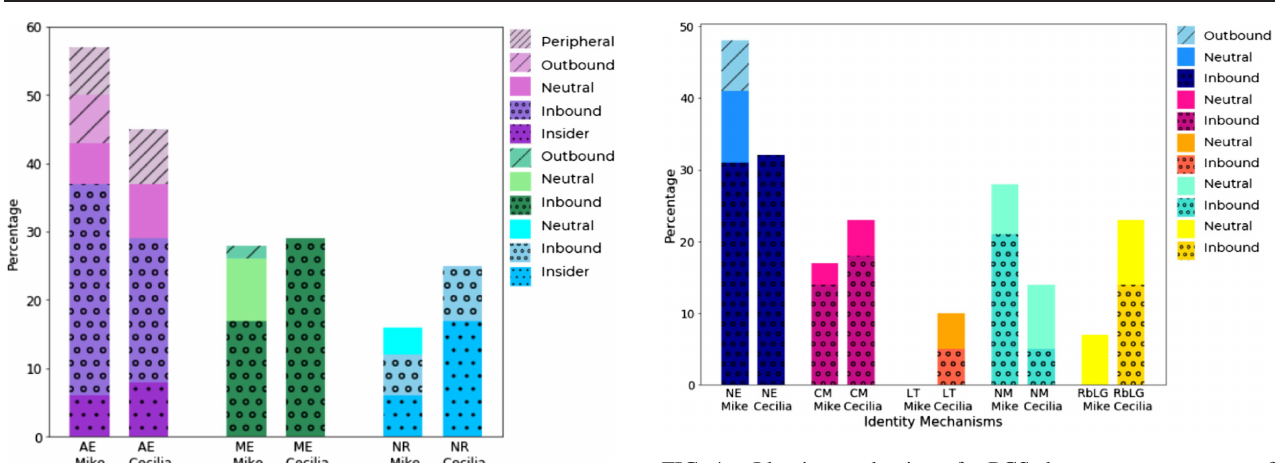
FIG. 4. Identity mechanisms for PCS shown as a percentage of all identity mechanism codes for both Mike and Cecilia. The codes have been separated into the subcode categories — inbound (circle), neutral, and outbound (diagonal lines) — to show move- ment between membership levels. Negotiated experiences (NE) was the only category with outbound